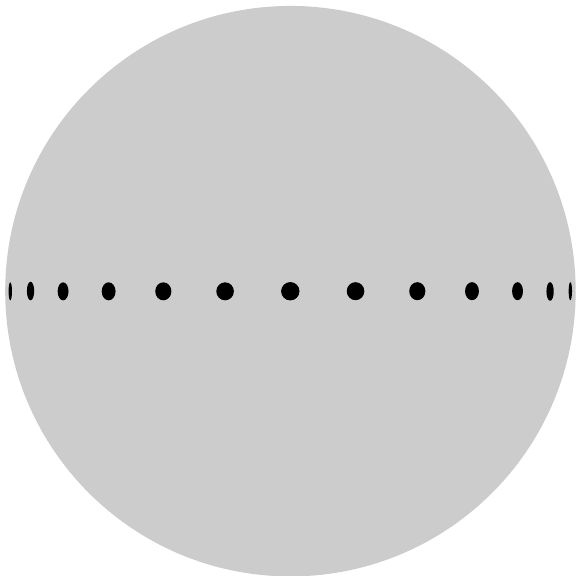
Fig. 1. Schematic illustration of the variation in the apparent (projected) area of a circular sunspot with an angular diameter of 1arc min during its passage across the solar disk. The daily posi- tions and areas of an idealised (purely umbral) sunspot on the solar equator are shown from 6 days before the sunspot reaches the cen- tral solar meridian to 6 days after it passes this meridian, as viewed from the Earth. The average equatorial synodic-solar-rotation pe- riod is assumed to be exactly 27 days, which corresponds to an apparent motion in heliographic longitude of 13.3 ◦ per